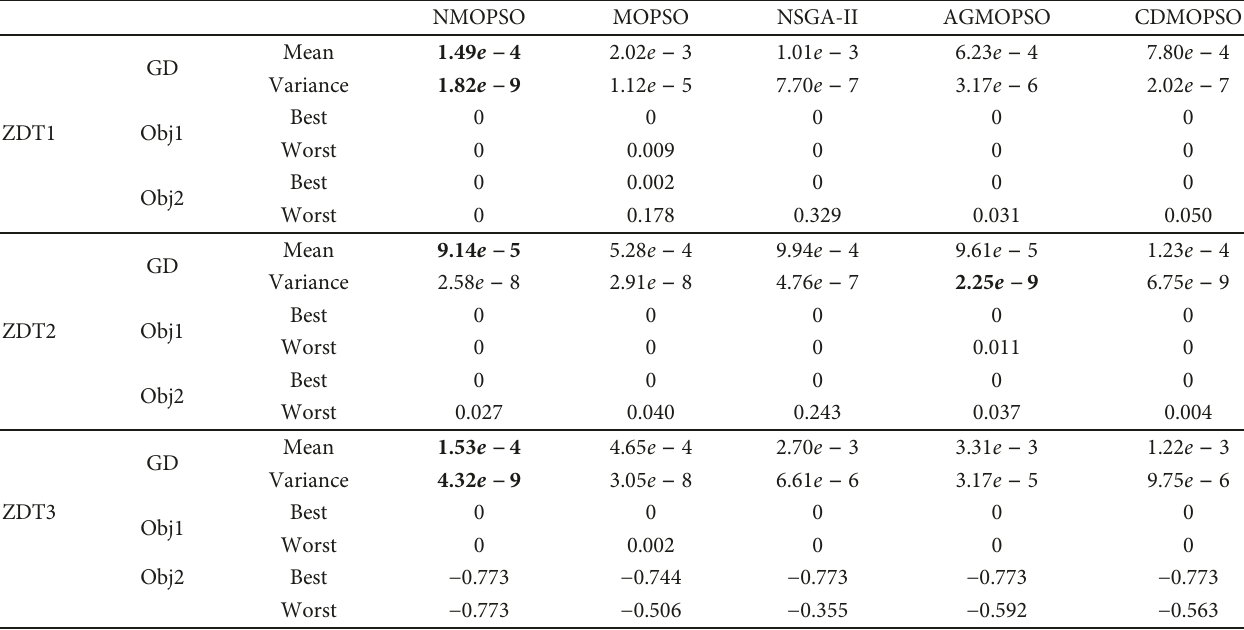
Table 1: The performance of fi ve